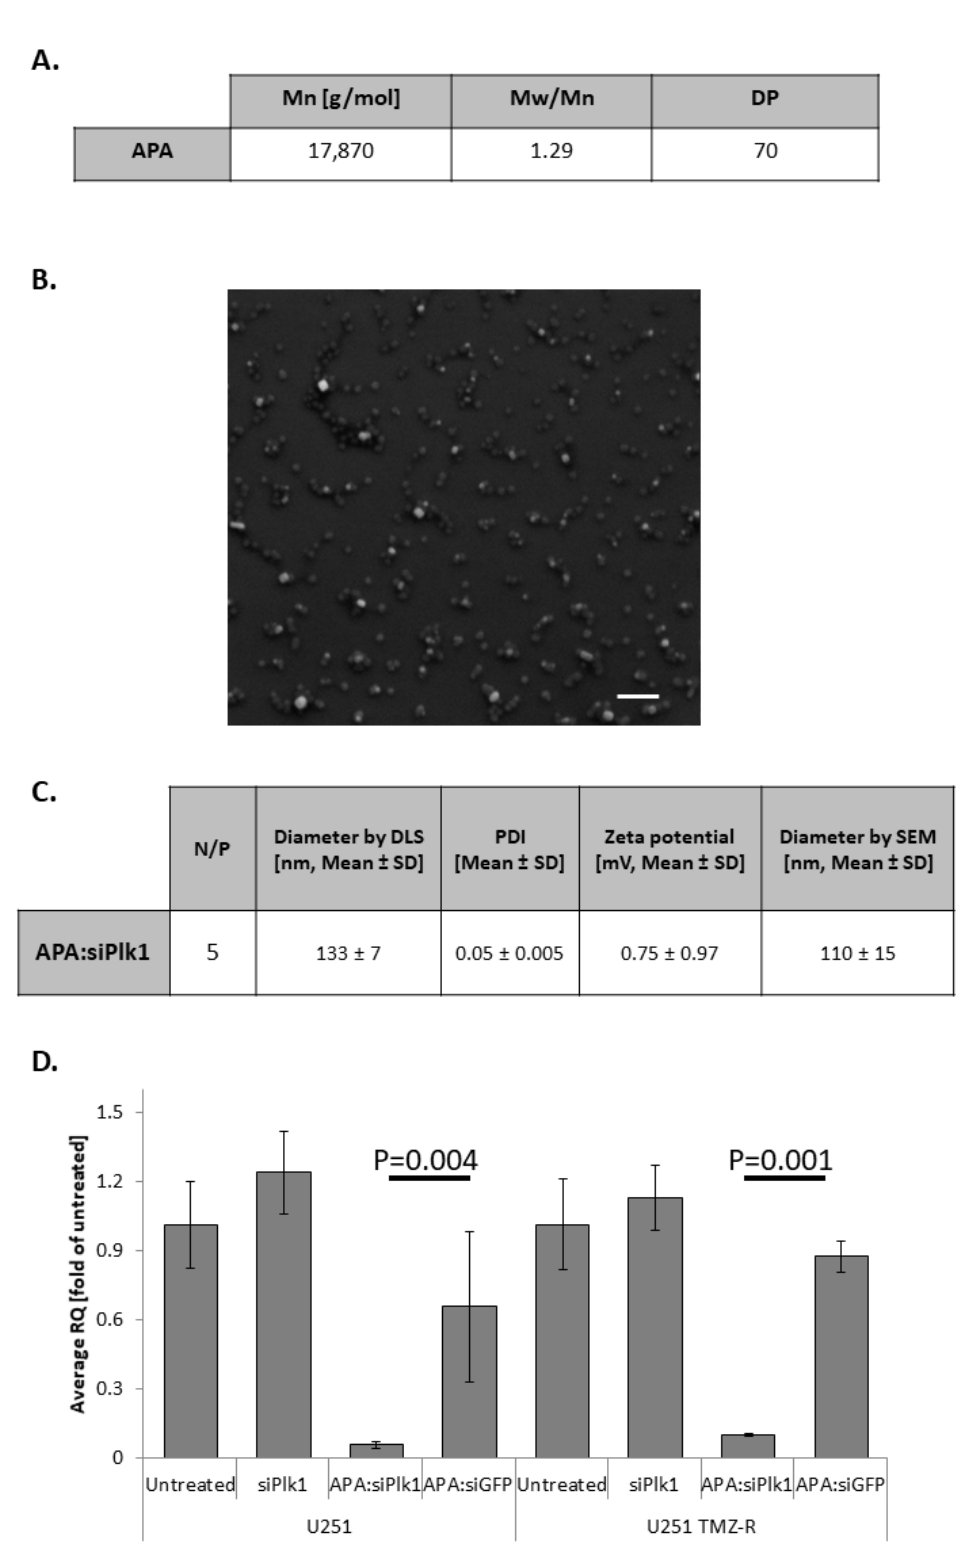
Figure 2. Physico-chemical characteristics and silencing activity of APA:siPlk1 polyplexes. ( A ) Table summarizing the Mw (Mn), PDI (Mw/Mn), and theoretical degree of polymerization (DP) as obtained by multi-angle light scattering (MALS). ( B ) Scanning electron microscope (SEM) image of the dry droplet of polyplexes (scale = 500 nm). ( C ) Table summarizing the hydrodynamic diameter, polydispersity index (PDI) and zeta potential of the main population of polyplexes, obtained by Mobius and PALS instruments, and the average diameter obtained by SEM. ( D ) Specific mRNA silencing obtained by RT-PCR, performed on U251 and U251 TMZ-R GB cells following treatment with APA:siPlk1